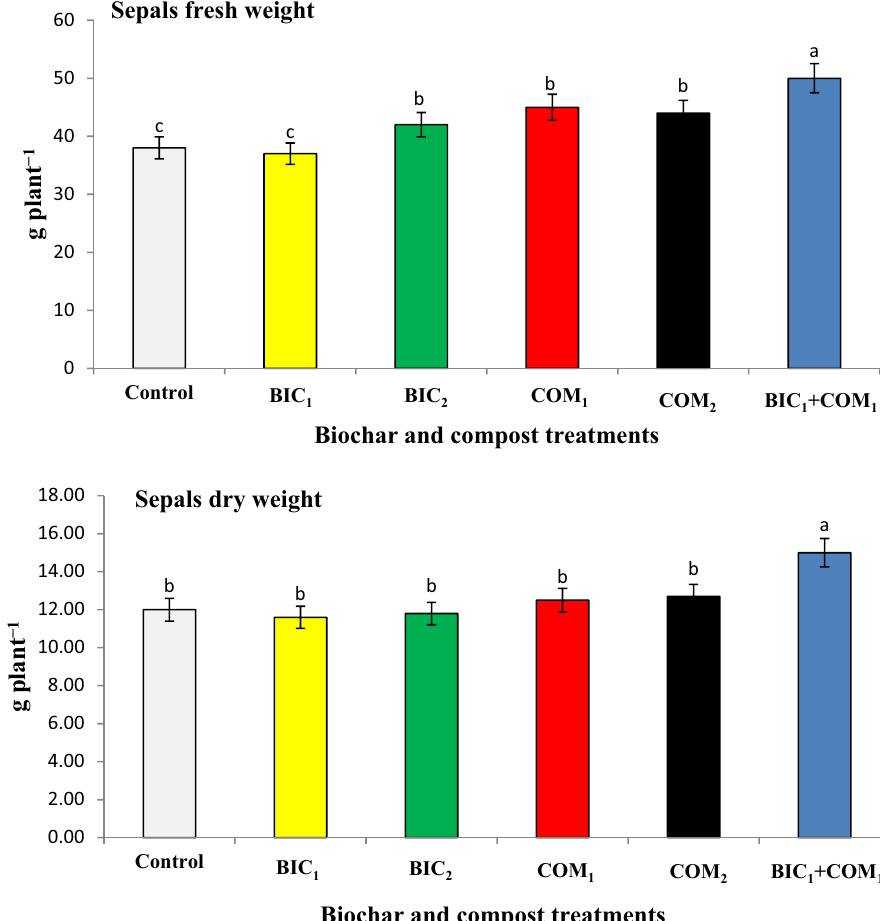
Figure 5. Effect of biochar and compost on the fresh (FW) and dry weight (DW) of sepal’s yield. BIC 1 and BIC 2 = biochar at rates of 1 and 2% (w/w), COM 1 and COM 2 = compost at rates of 1 and 2% (w/w), and BIC 1 + COM 1 = mixture of the two amendments at 1% (w/w) of each. Means (± SD, n = 5) denoted by the same letter indicate no significant difference according to Tukey’s multiple range tests at p <